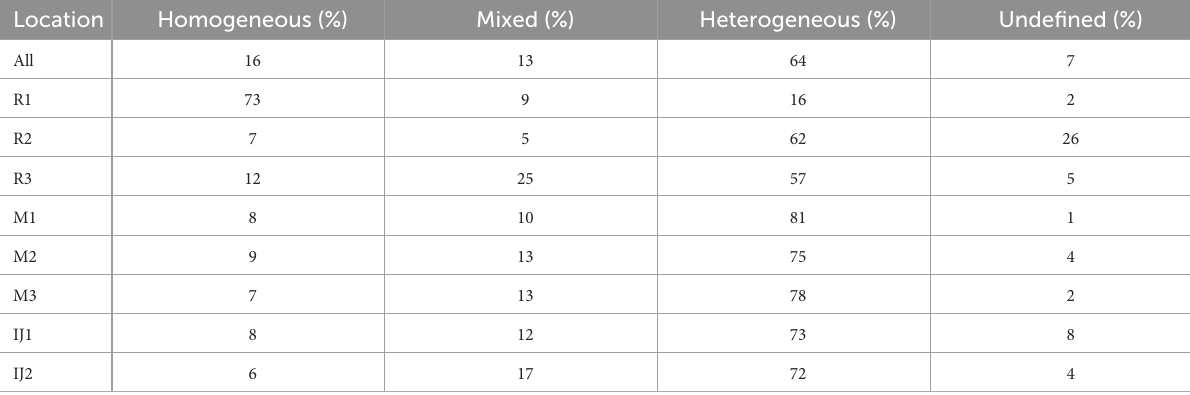
TABLE 3 Litter heterogeneity per sample site, based on mean mass with a 90% confidence boundary and 10% deviation from the mean, in the river Rhine (R1, R2, R3), Meuse (M1, M2, M3), and IJssel (IJ1, IJ2).